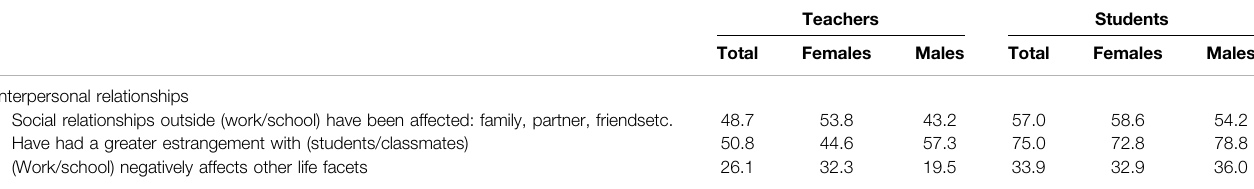
TABLE 7 | Change in interpersonal relationships resulting from the shift in teaching modality in teachers and students.